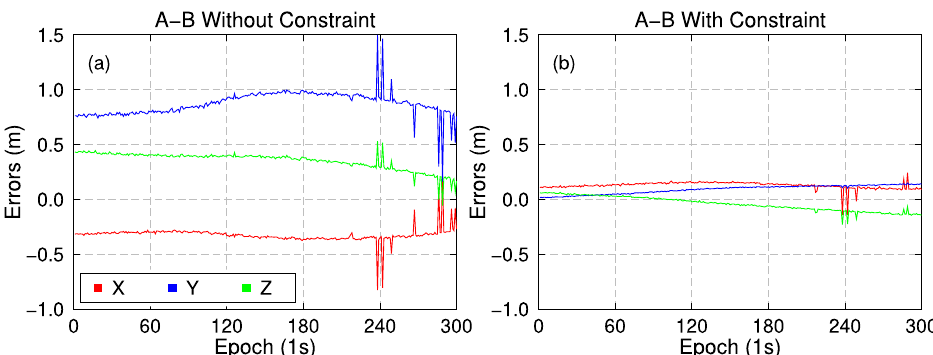
Figure 13. Widelane ambiguity float solutions of baseline A–B without ( a ) and with ( b ) static levelling constraint.